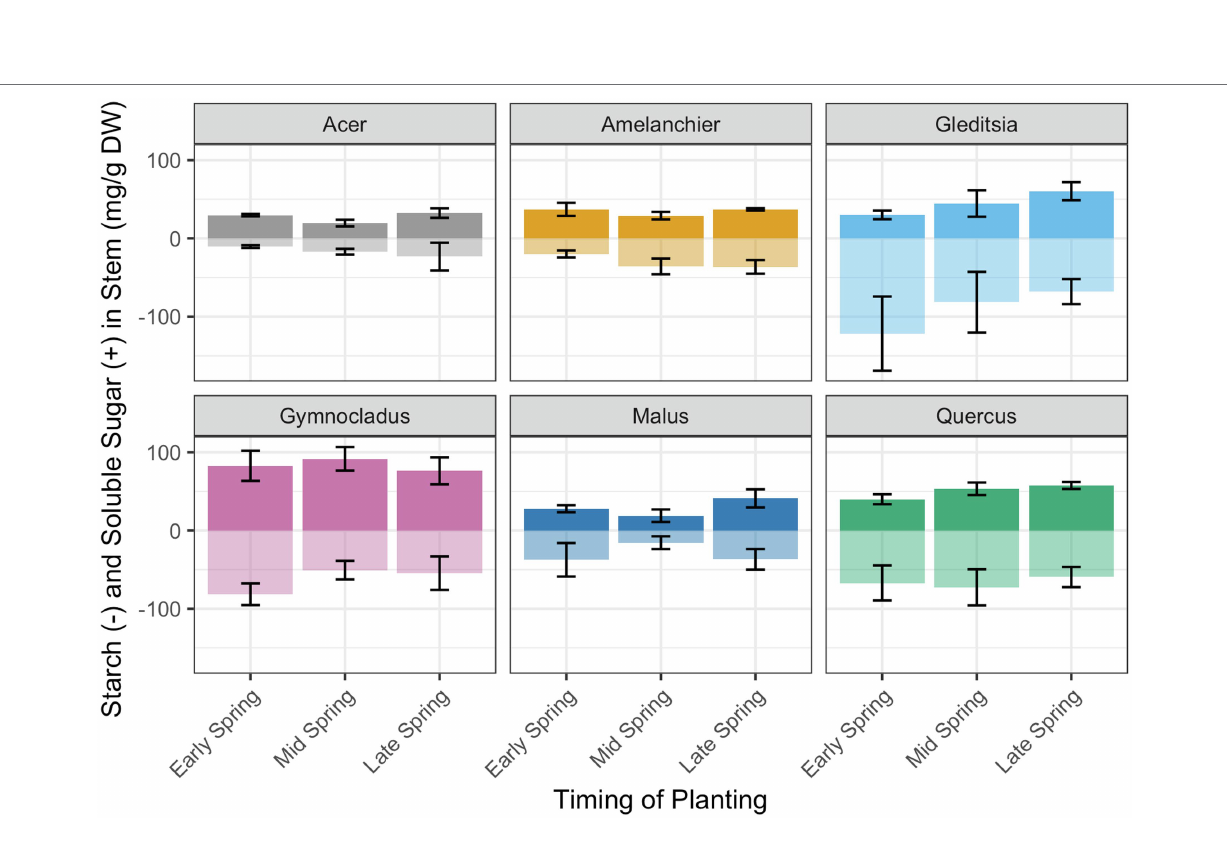
FIGURE 5 | Total non-structural carbohydrate concentration and relative proportion of starch (transparent bars, below midline) and soluble sugars (solid bars, above midline). The specific dates for the timing of planting categories are in Table 1 . There was evidence of a significant positive relationship of planting week on total NSC concentration for Amelanchier ( p < 0.01; details in text and Table 1 ) and evidence of a significant negative relationship for Gymnocladus ( p < 0.05; details in text and Table 1 ). Error bars indicate standard deviation for soluble sugar and starch concentration separately. Soluble sugars and starch concentrations were not tested separately in linear regression